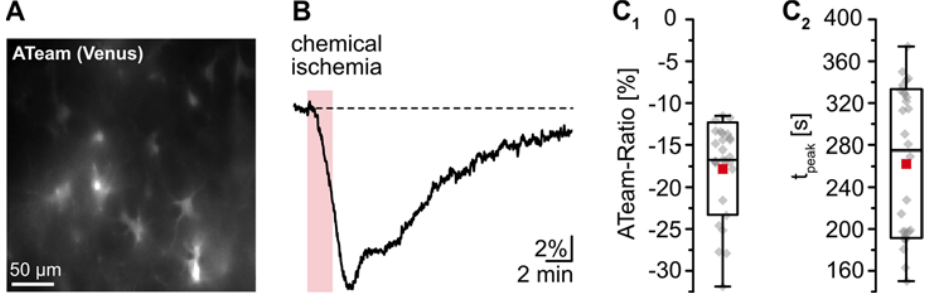
Figure 1. Reduction of astrocytic ATP levels by chemical ischemia for 2 min. ( A ) Image of the Venus fluorescence of ATeam, expressed under the GFAP promotor in an organotypic tissue slice. ( B ) Changes in the ATeam ratio of an individual astrocyte evoked by chemical ischemia (indicated by the red box). ( C ) Box plots of peak changes in astrocytic ATeam ratio ( C 1 ) and the time ‐ to ‐ peak ( C 2 ) upon chemical ischemia. Shown are individual data points (grey diamonds), means (squares), medians (horizontal lines), SDs (boxes), and min/max (whiskers).